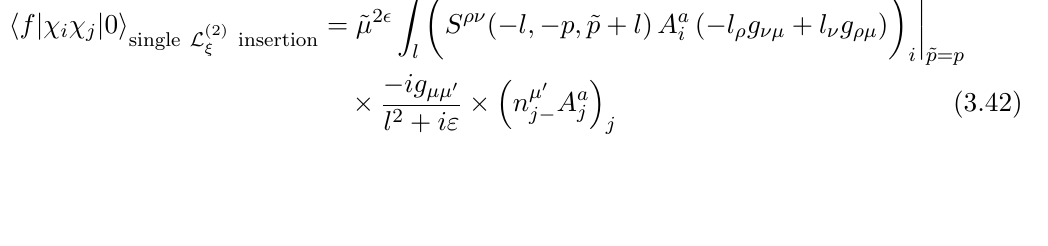
Figure 6 . As (cid:12)gure 2, but for an insertion of choosing up to two emissions. Dashed lines should be replaced with subdiagrams according to the lower panel of (cid:12)gure 2. In addition, also emission directly o(cid:11) the current is